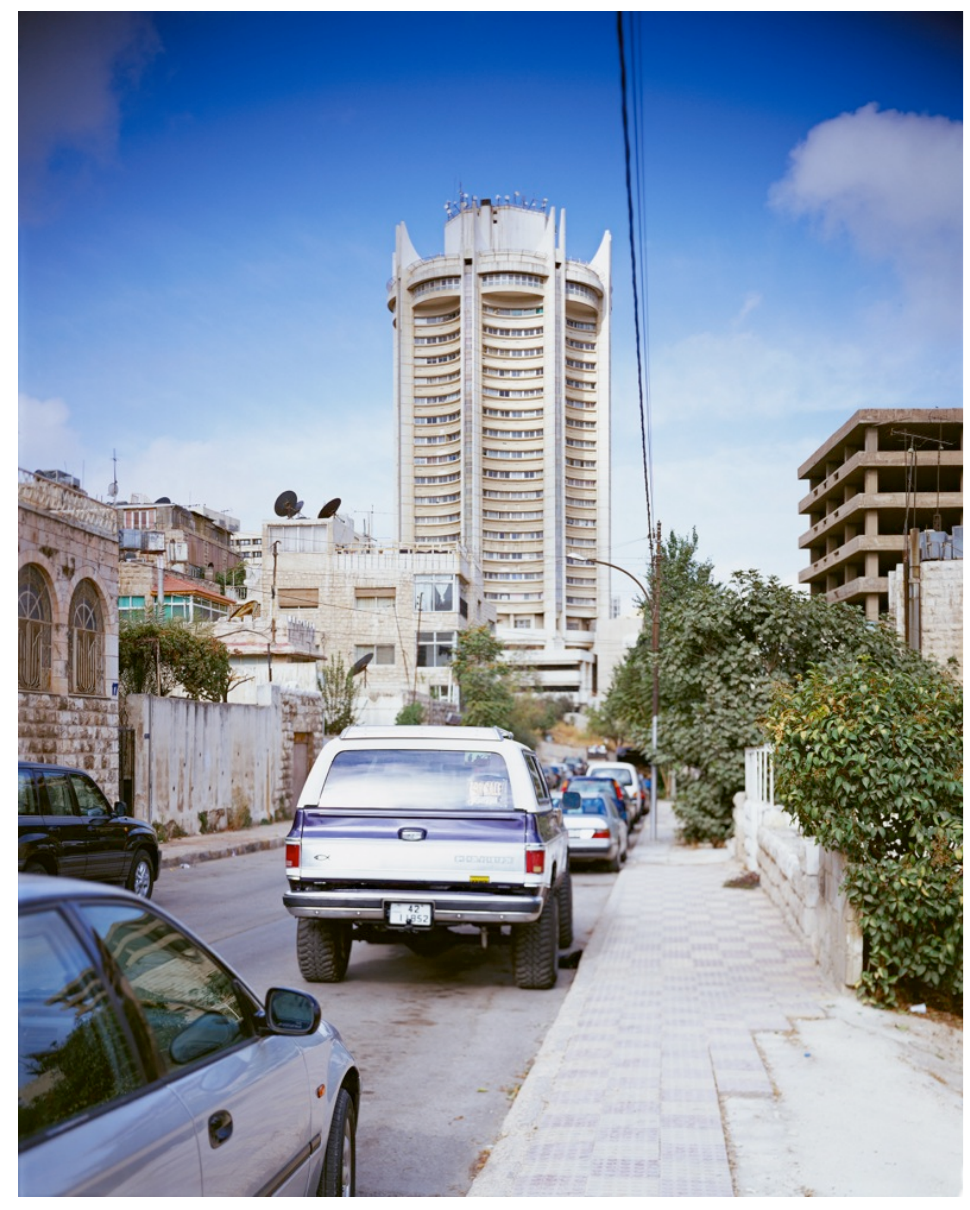
Regina Mamou, Untitled (InterContinental) from the series Mapping Collected Memory , 2009–2010. Digital C-print. 40 x 32 in. (101.60 x 81.28